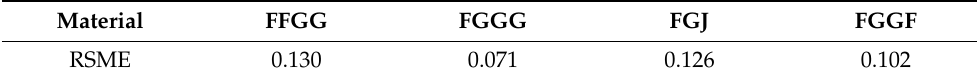
Table 5. The RMSE between analytical and experimental